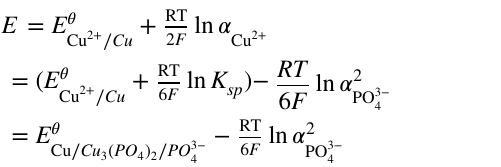
Fig. 1 a Digital photo and b XRD pattern of Cu 3 (PO 4 ) 2 . c Galvanostatic discharge/charge profiles of Cu 3 (PO 4 ) 2 between −0.7 and 0.4 V versus Ag/AgCl at 100 mA g −1 , and d the corresponding cycling